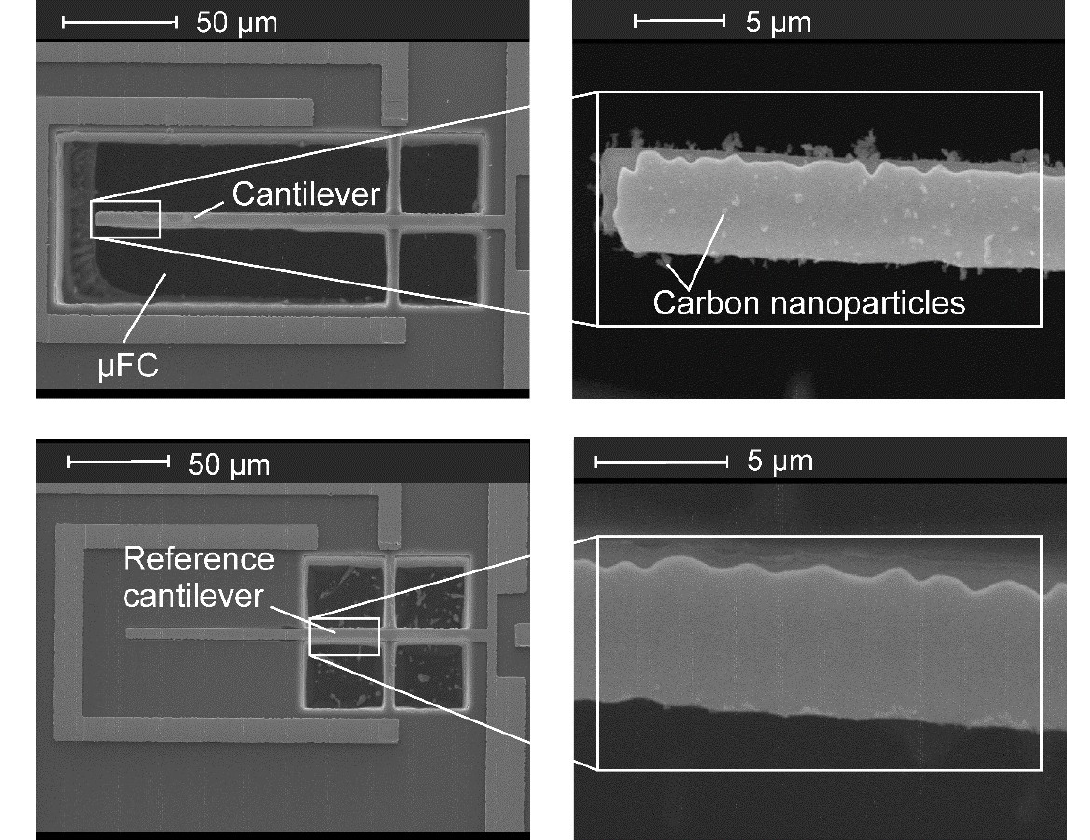
Figure 5. Scanning electron micrograph (SEM) of a PMC-µFC after carbon aerosol particles sampling using V es = −30 V at a mass concentration in the chamber of 10 µg/m 3 for 1 h. Sampled carbon NPs are visible only on the cantilever in a free-etched µFC ( upper ), while the reference structure without µFC does not show any precipitated particle ( lower ).